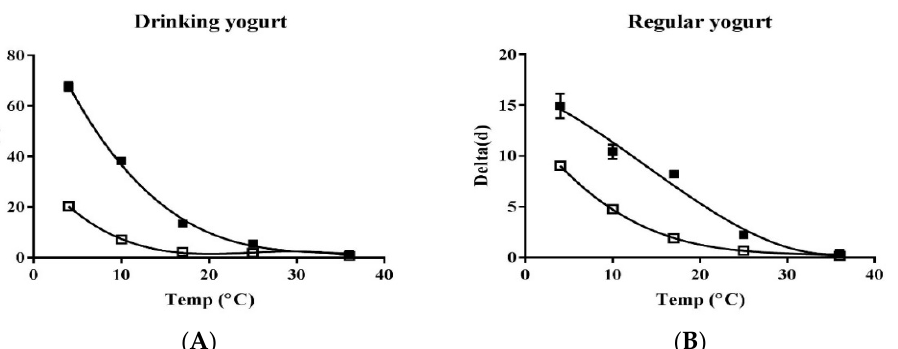
Figure 3. Secondary models for delta values of Listeria monocytogenes (□); and EHEC ( ■ ) in drinking ( A ) and regular yogurt ( B ). Table 1. Survival kinetic parameters of Listeria monocytogenes (LM) and EHEC in yogurt 1 . Drinking Regular Pathogens Temperature (°C) Delta (Day)